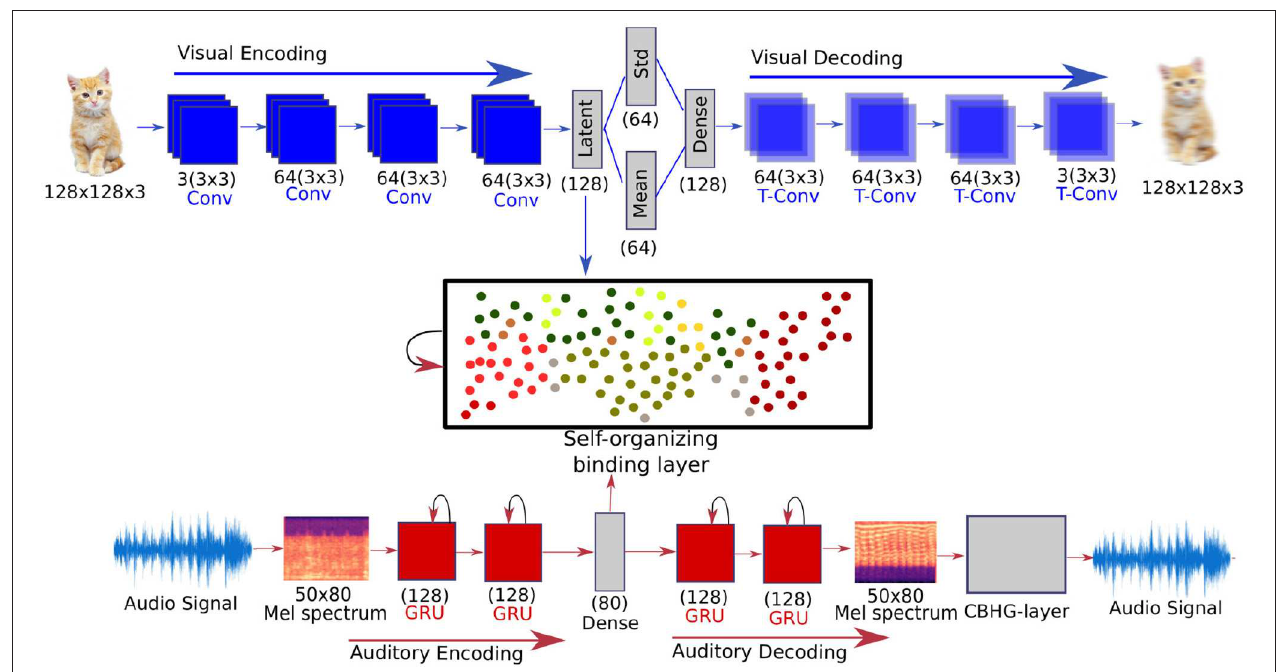
FIGURE 1 | An overview of the proposed multisensory binding model with the audio/visual autoencoder structures and the recurrent self-organizing binding layer. The auditory autoencoder uses a CBHG network to reconstruct audio signals from the Mel Spectrum (Lee et al., 2017).